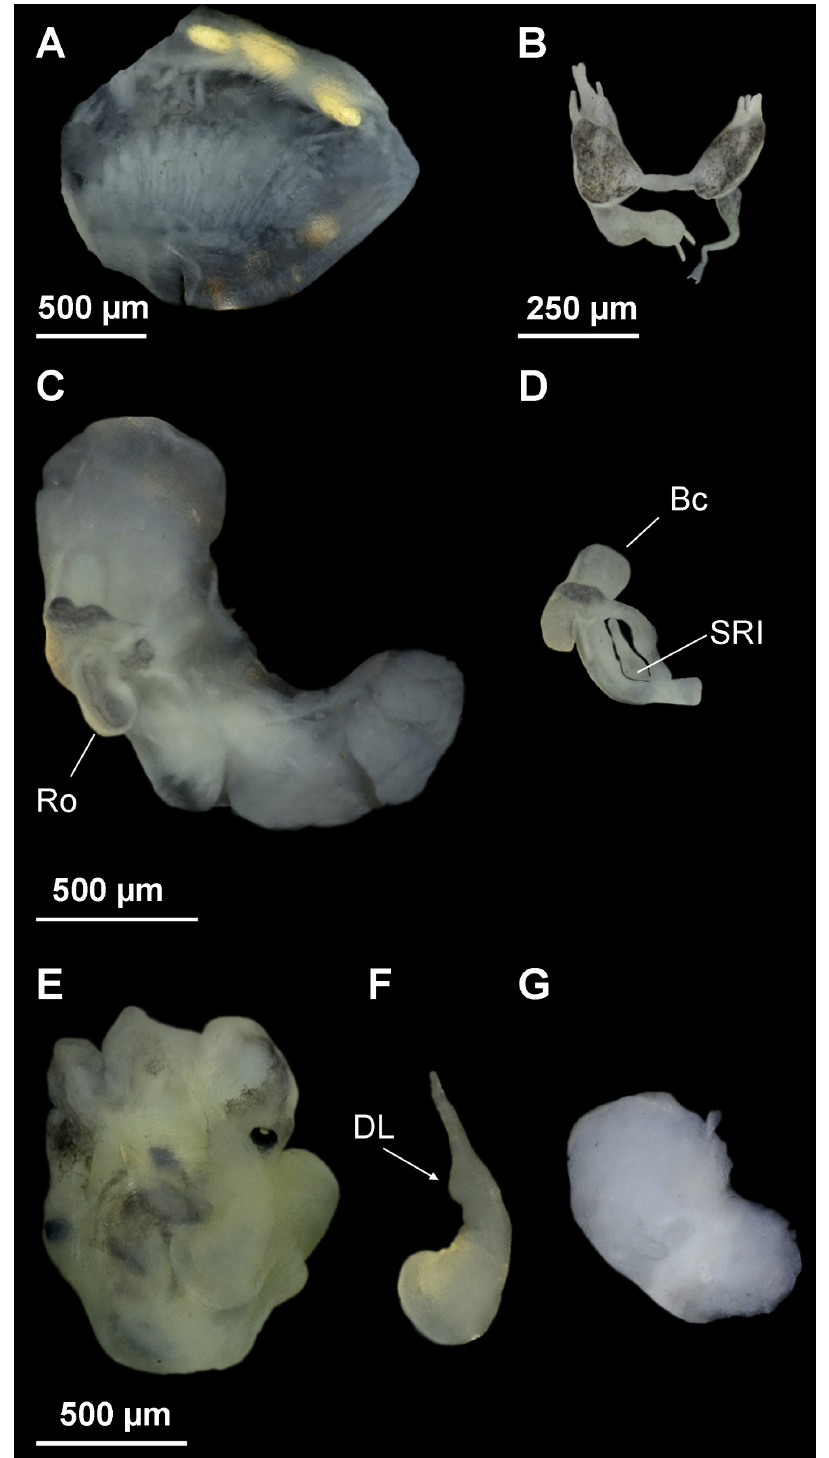
Fig. 5. Anatomy of Intermaria kermanshahensis (Glöer & Pešić, 2009) gen. et comb. nov. from a spring near Sarabe - Sahneh city, Kermanshah Province, Iran. A . Ctenidium and osphradium. B . Partial nervous system. C . Female genitalia. D . Bursa copulatrix and seminal receptacle. E–F . Head of a male and penis. G . Prostate gland. Anatomical abbreviations given in the Material and methods section, except DL (distal